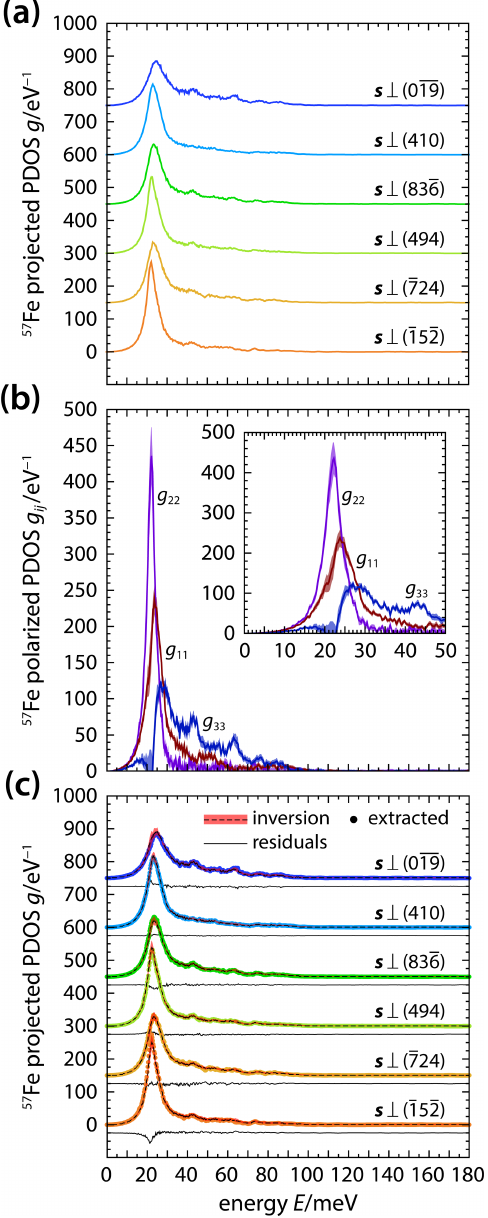
Figure 2. Partial projected PDOS (a) and tensor components of the polarized PDOS (b) for modes that displace 57 Fe atoms in δ -(Al,Fe)OOH single crystals. The projected PDOS values (a) were extracted from NRIXS spectra recorded with the X-ray beam incident along different directions s and analyzed using a ten- sor description. The comparison of inversion results with the ex- tracted PDOS (c) indicates that a second-rank tensor captures the anisotropy of the projected PDOS. The tensor components g 11 , g 22 , and g 33 of the polarized PDOS (b) illustrate how displacements of resonant 57 Fe atoms along the crystallographic a , b , and c axis, re- spectively, contribute to the projected PDOS. Extracted PDOS, in- version results, and residuals (a, c) are vertically offset for clarity. Shaded areas indicate uncertainties.